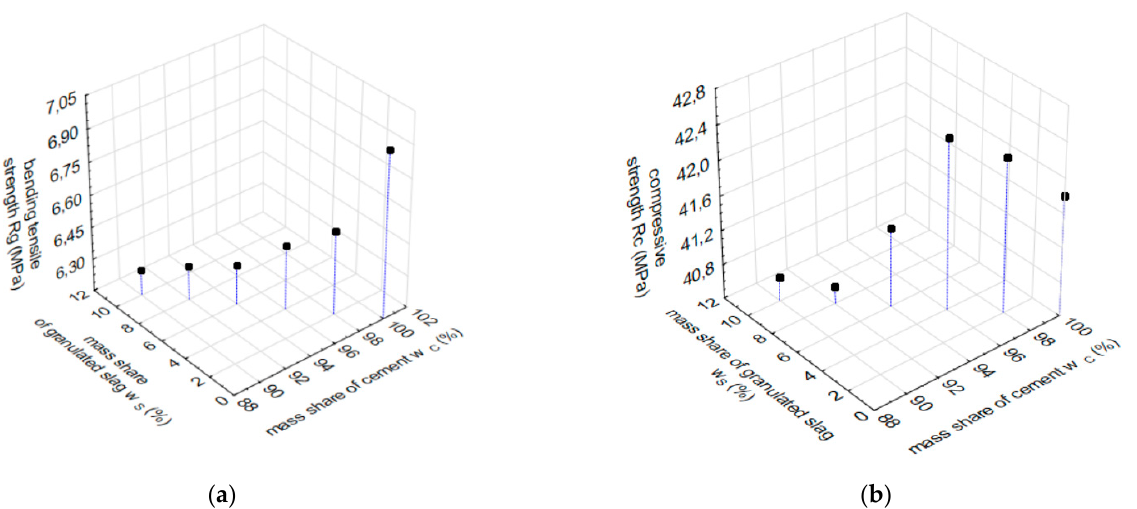
Figure 5. ( a ) Dependence of mean flexural tensile strength, Rg, and ( b ) compressive strength, Rc on the simultaneous change of cement and granulated blast furnace slag.